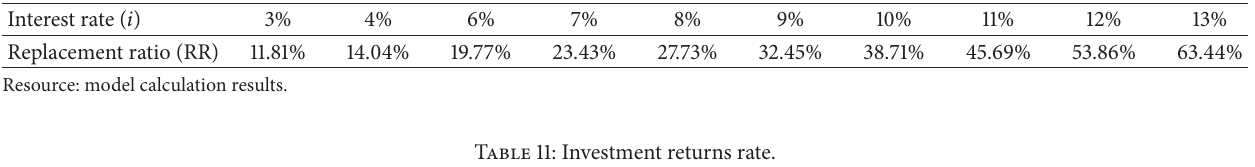
Table 10: Forecast relationship (partial).